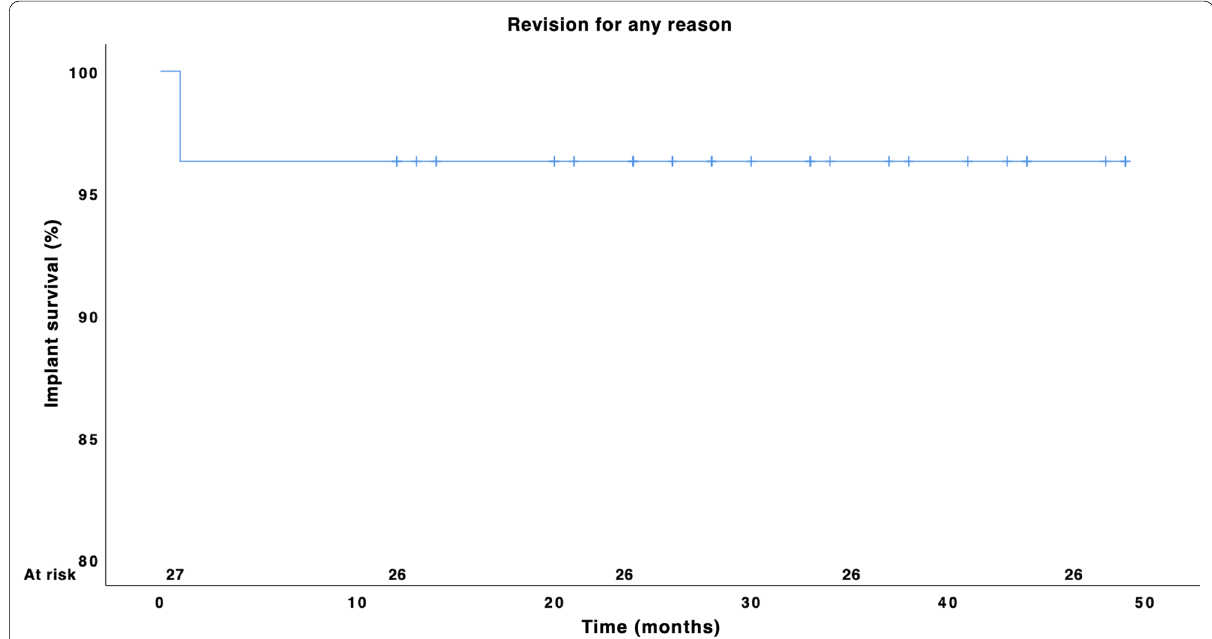
Fig. 5 Kaplan–Meier survival plot for the endpoint of revision for any